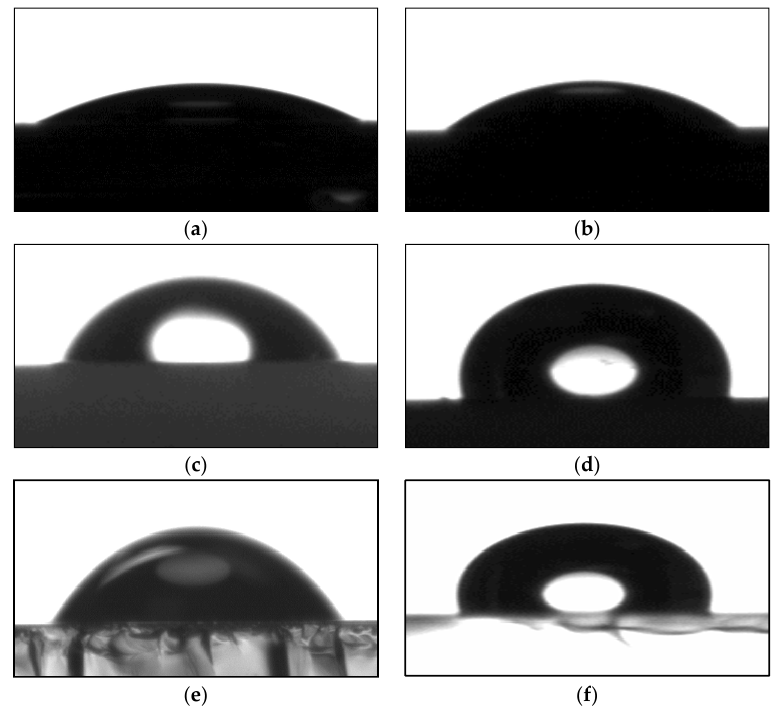
Figure 1. Contact angle measurements of ( a ) Si (22°–24°); ( b ) Si ‐ APTES (34°–36°); ( c ) GaAs (75°–77°); ( d ) GaAs ‐ ODT (102°–105°); ( e ) ITO (40°–45°) and ( f ) ITO ‐ ODT (102°–105°).